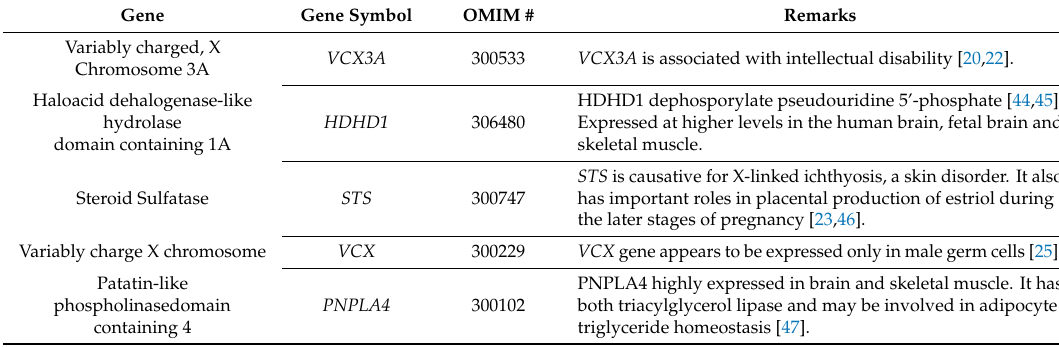
Table 2. Genes involved in Xp22.31 microdeletion.